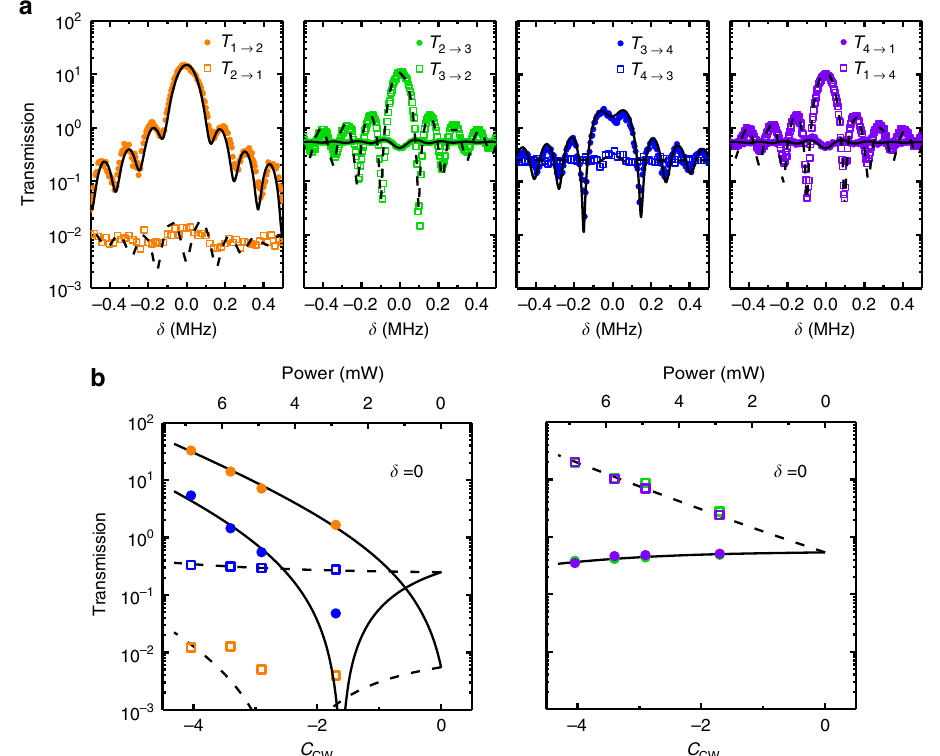
Fig. 3 Demonstration of a directional ampli fi er with a blue-detuned control fi eld. a Typical measured transmission spectra for the function of the directional ampli fi er. The solid circles represent T i → i + 1 and the open squares represent T i + 1 → i . The incident control power is 5.8 mW, corresponding to C cw = − 3.4. b Transmittance obtained at δ = 0 versus C cw . The lines in a , b indicate theoretically expected values based on the parameters κ /2 π = 16.2 MHz, ω m /2 π = 90.47MHz, and γ /2 π = 22